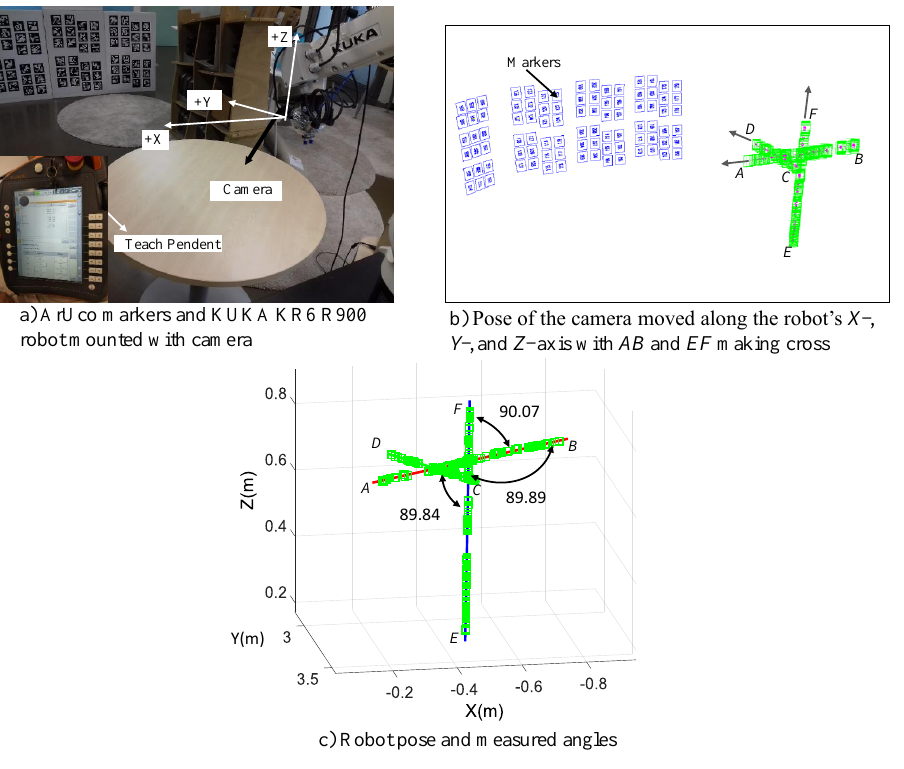
Figure 12. Evaluation of measurements using the ArUco markers and monocular camera. Table 3. Evaluation of measurement performance using monocular camera and ArUco